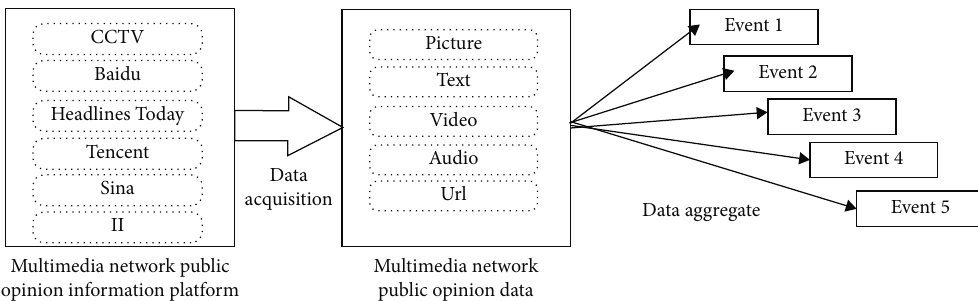
Figure 2: Multimedia network knowledge base group interoperability data summary